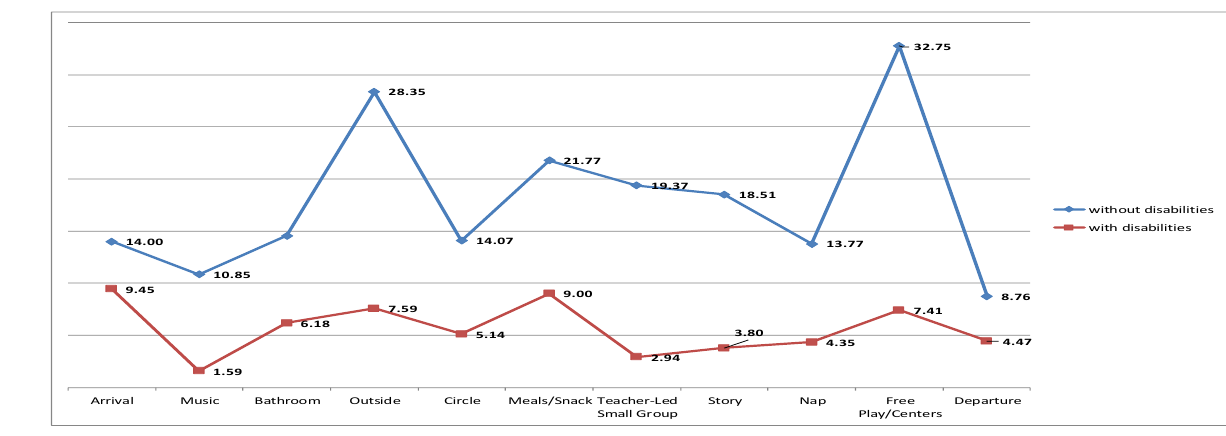
Figure 1. E = engagement.